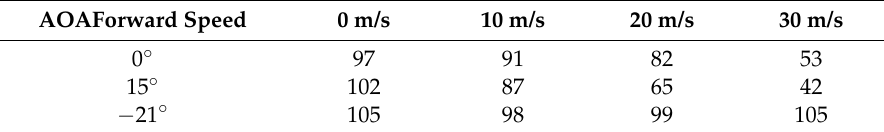
Table 4. Rotational speeds of the lift fan during the transition (rpm).